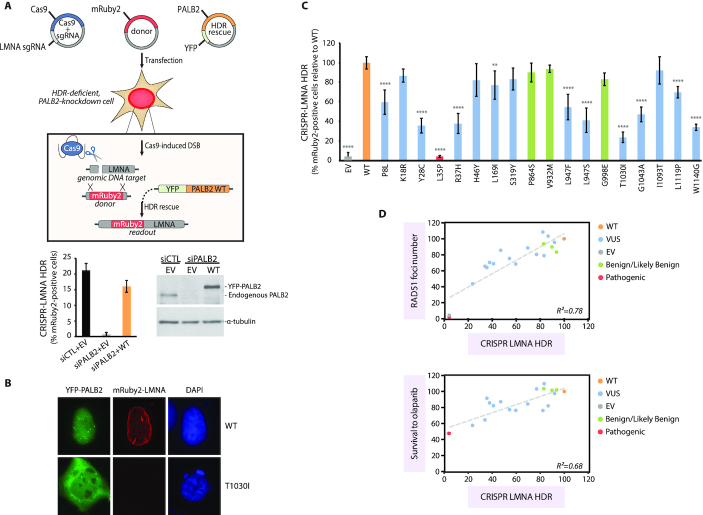
HDR activity of PALB2 variants using the CRISPR-LMNA system. (A) Schematic representation of the system. The CRISPR-LMNA system measures the HDR-dependent insertion of mRuby2 into a Cas9-mediated DSB in the LMNA gene, resulting in cellular expression of mRuby2-tagged lamin A/C (LMNA) that serves as readout for HDR activity. Also shown is the typical level of HDR activity of PALB2 after siRNA knockdown and complementation in U2OS cells, with accompanying immunoblots. Data in the bar graph represents mean percentages (± SD) of mRuby2-positive cells among the cell population expressing the YFP-empty vector or siRNA-resistant PALB2 WT, as determined by fluorescence microscopy 72 h post-nucleofection of the CRISPR-LMNA system. (B) Representative fluorescence microscopy image of a cell expressing mRuby2-LMNA after successful homology directed repair, as seen in PALB2-depleted cells complemented with siRNA-resistant YFP-PALB2 WT (top). Cell negative for mRuby2-LMNA expression as typically found after complementation with the p.T1030I variant (bottom). (C) Quantification of HDR activity after complementation of PALB2-knockdown U2OS cells with empty vector or the indicated siRNA-resistant PALB2 construct. Data represents mean relative percentages (± SD) of mRuby2-positive cells among the YFP-positive population from 3 independent experiments (n > 300 YFP-positive cells per condition) relative to the WT condition. VUS are depicted in blue, p.L35P pathogenic variant in red, benign/likely benign variants in green, while PALB2 wild-type and the empty vector are highlighted in orange and grey, respectively. Statistical significance was accessed by one-way ANOVA followed by Dunnett's post hoc analysis. (**) P< 0.01 and (****) P< 0.0001. (D) Scatter graphs with regression lines (in grey) correlating HDR activity with the mean number of RAD51 foci per cell or cell survival to olaparib. Values are expressed in percentage relative to WT (set to 100%). R2 values are shown.